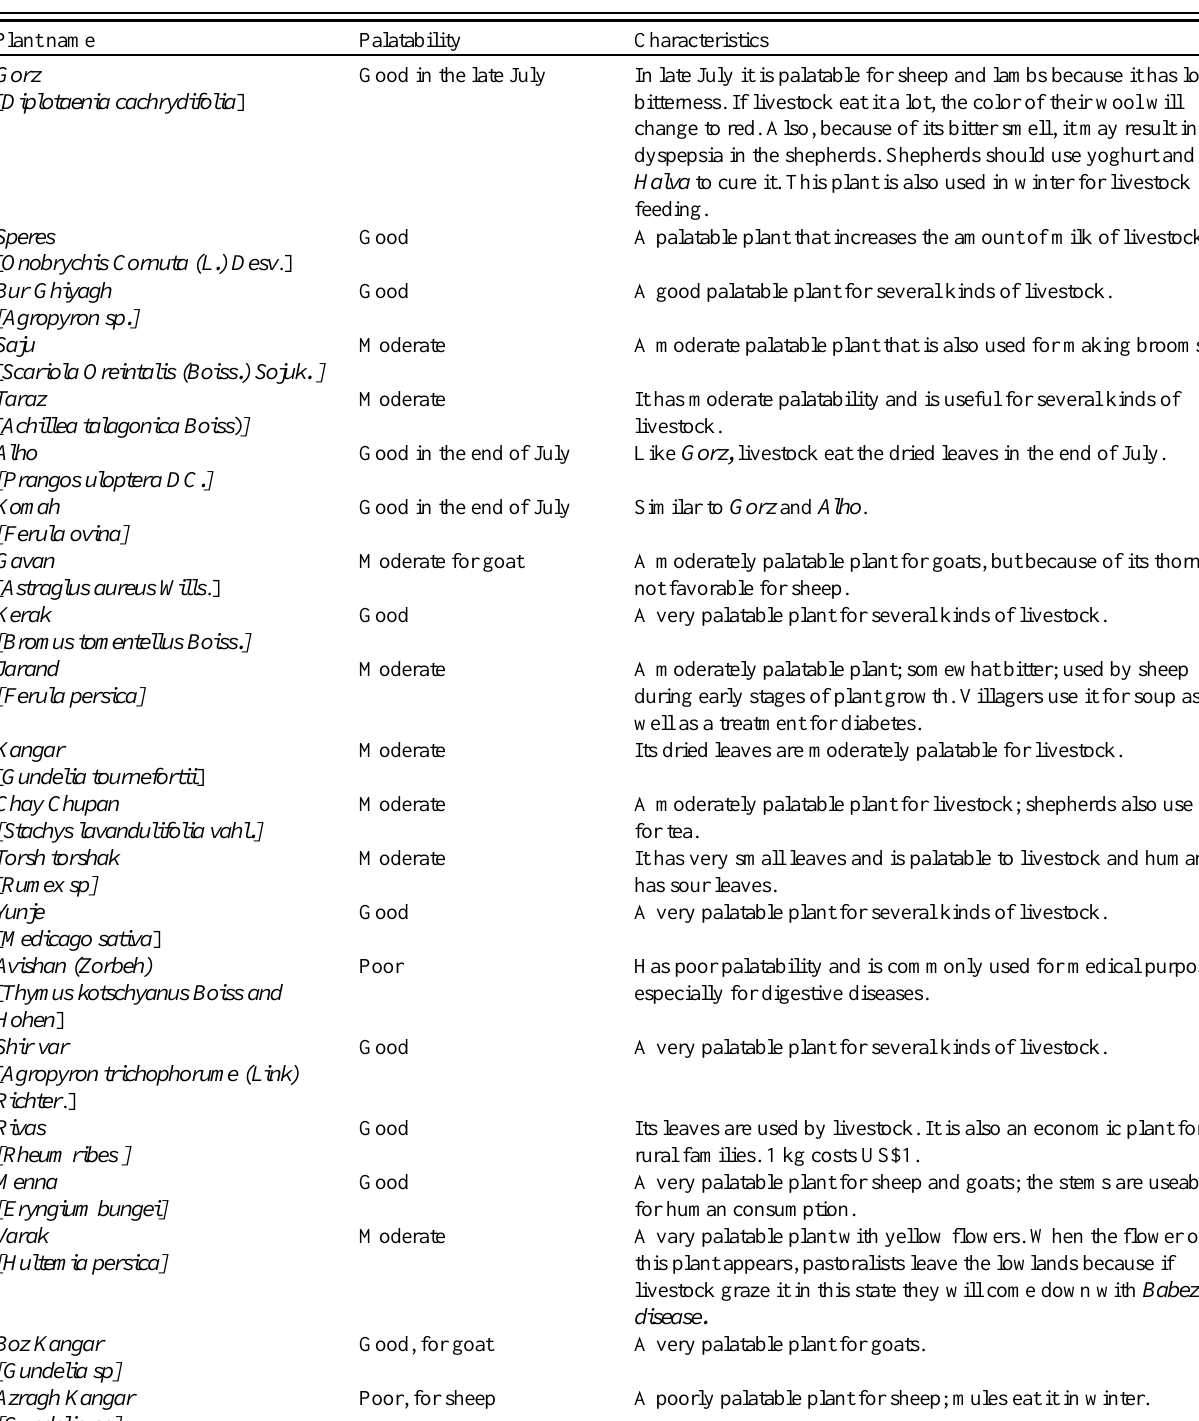
Table 3 . Some rangeland plants in the Saman Orfi of Nariyan village: pastoralists’ assessment of palatability for